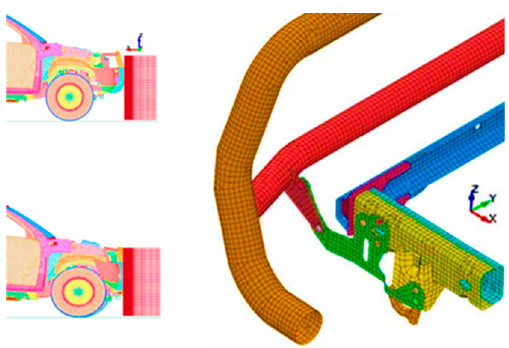
Figure 3. Over the bumper type front protection system (FPS) mount and its mating parts.